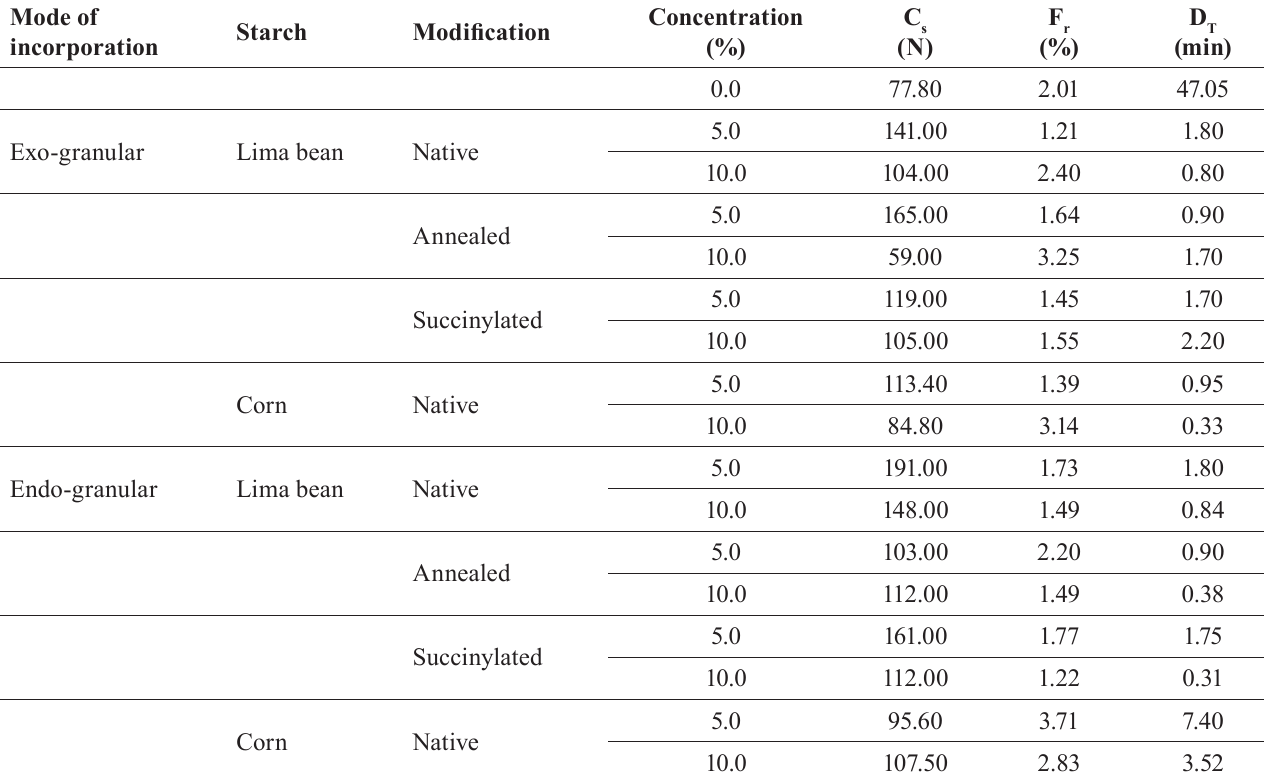
TABLE III - Values of crushing strength C tablets Mode